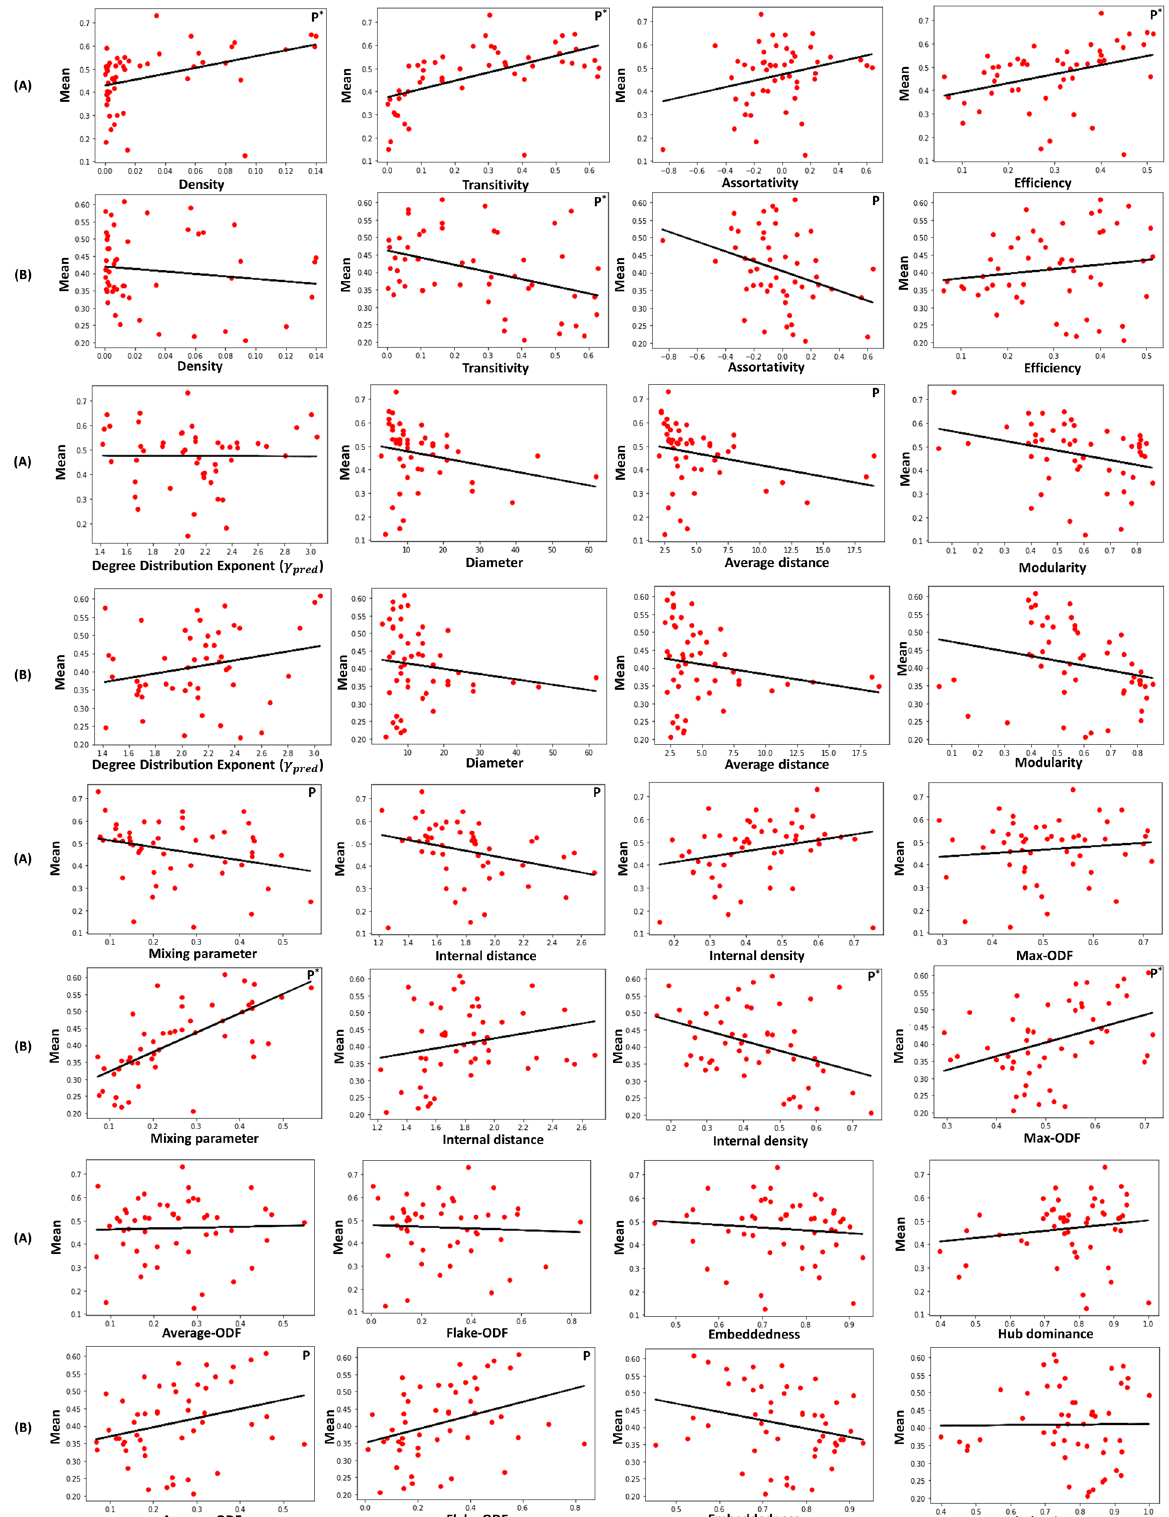
Figure 7. Relationship of the mean of the correlation between classical, local ( A ), and global ( B ) community- aware centrality measures with respect to the topological properties of real-world networks. The line is fitted by linear regression using ordinary least squares. “P” indicates p ≤ 0.05 . “P” and * indicate p ≤ 0.01